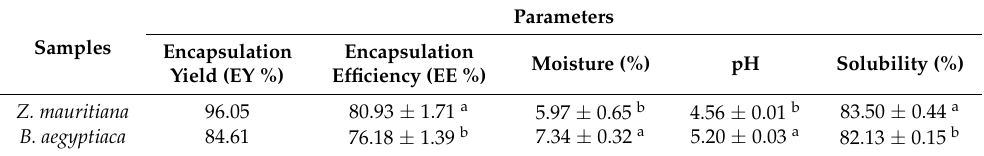
Table 4. Physicochemical parameters of microencapsulated Ziziphus mauritiana and Balanites aegyptiaca extracts